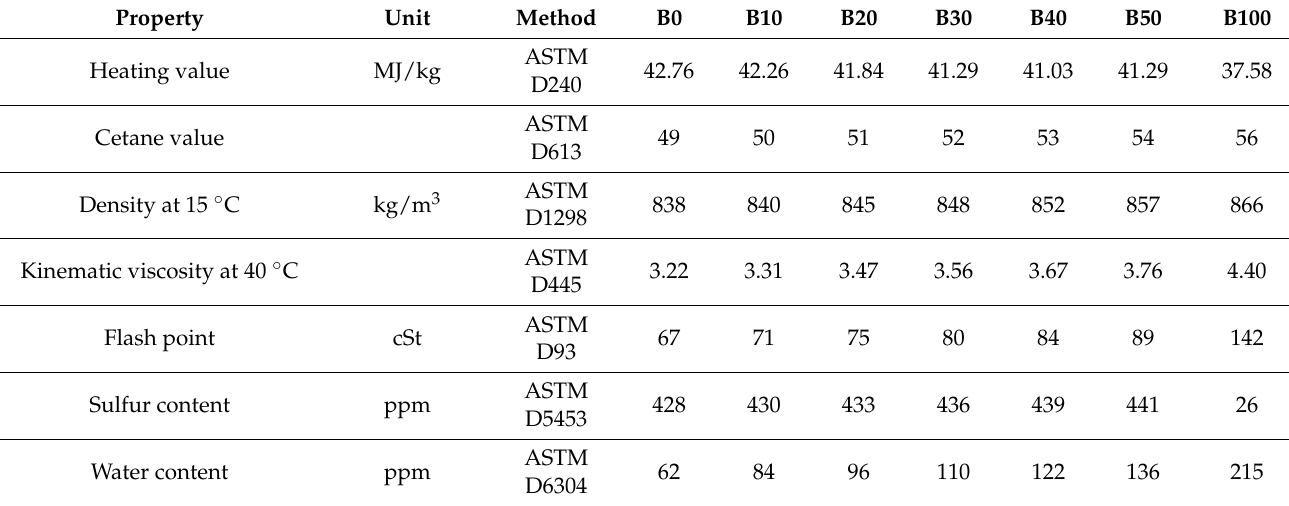
Table 2. Properties of test fuel.